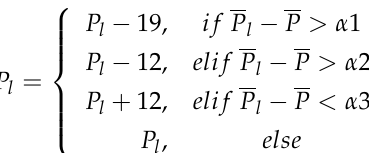
Figure 6. Correcting abnormal contours above or below the melody contours. The red dot line is the average pitch and blue lines are melody contours. Step ( a ) show an abnormal contour above the red dot line and step ( b ) shows an abnormal contour below the red dot line. Both of them have been corrected.